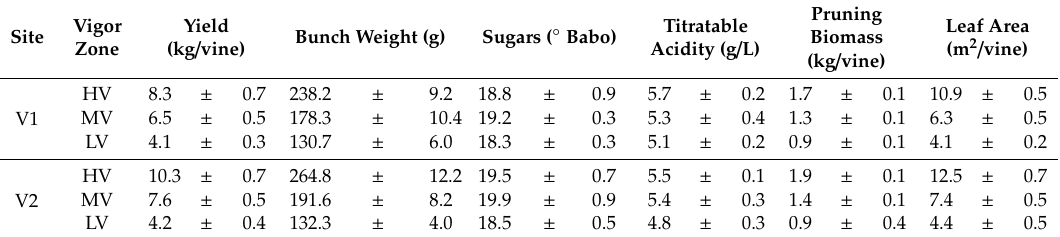
Titratable Acidity (g /